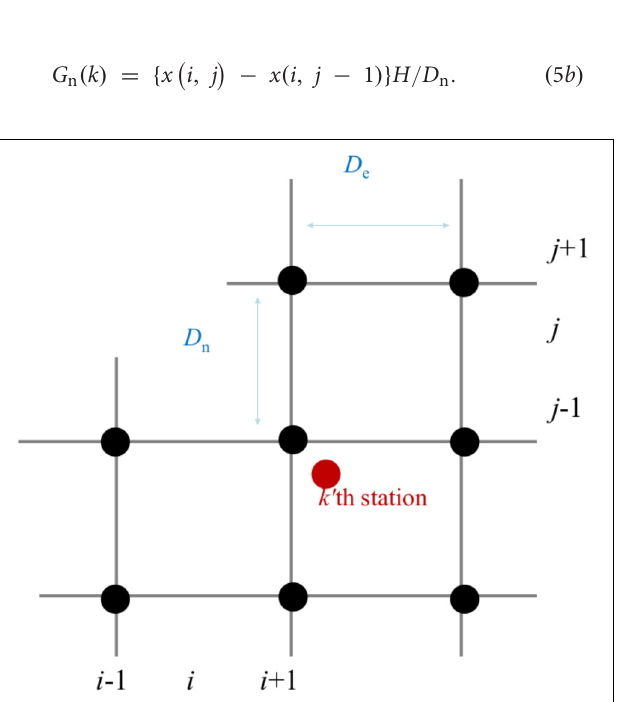
FIGURE 3 | Inversion scheme of the sea-level ZWD. We estimate ZWD at grid points, with the east–west separation of D e (0.20 ◦ ), and north-south separation of D n (0.15 ◦ ), as the parameters. We used G at all the stations and ZWD at stations with altitudes lower than 100 m as the input data. The observation equation of the ZWD at the central grid ( i , j ) is given by Eq.